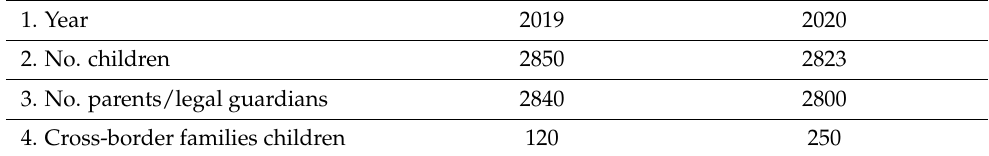
Table 1. Study group description.